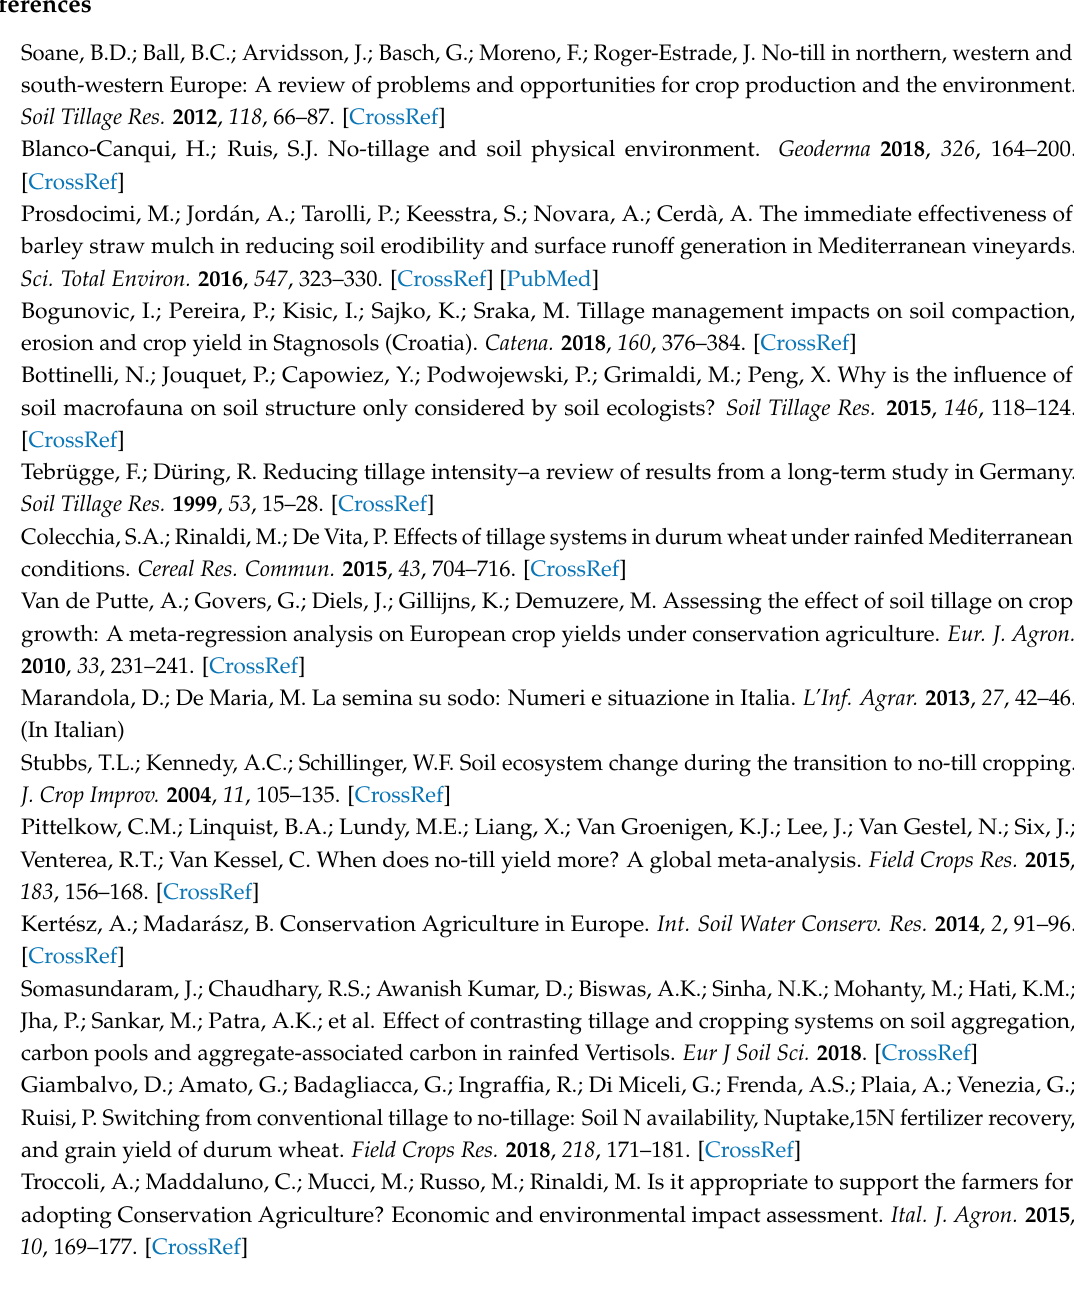
Table S1: Summary of the main cultivation practices carried out at the investigated sites during the growth season